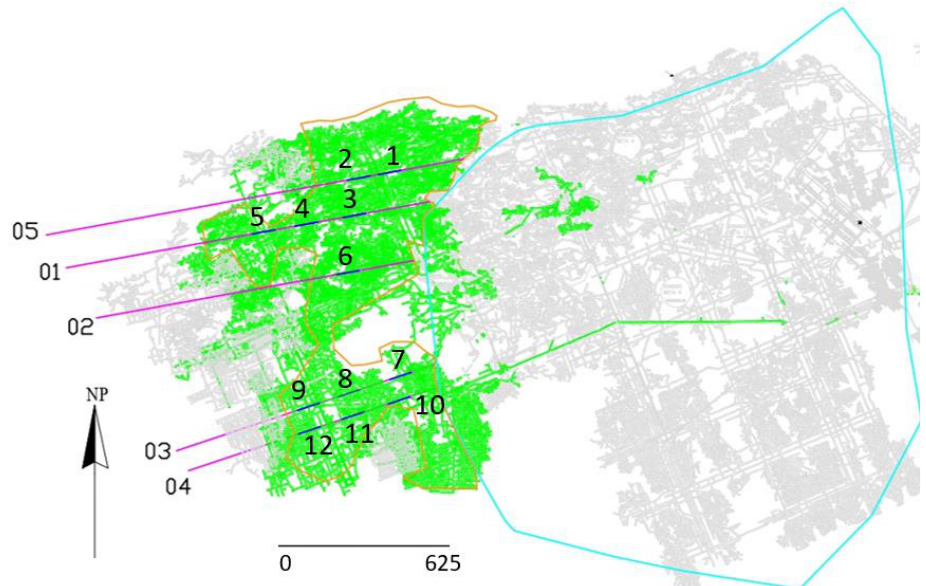
Figure 1. The mining area, with the two different perimeters, the five profiles and the twelve selected zones shown. The numbers on the left show the ID of each profile (from 01 to 05). The numbers enclosed in the orange perimeter show the ID of each analysed zone (01 to 12).